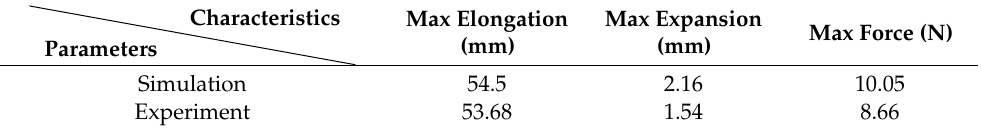
Figure 6. The bellows actuator’s actual performances ( a ) The actuator’s actual elongation performance; ( b ) The actuator’s actual expansion performance; ( c ) The actuator’s actual thrust force performance; ( d ) The histogram of the actuator’s robot section manufacturing error. Table 2. Comparison of the bellows experiment and simulation data.